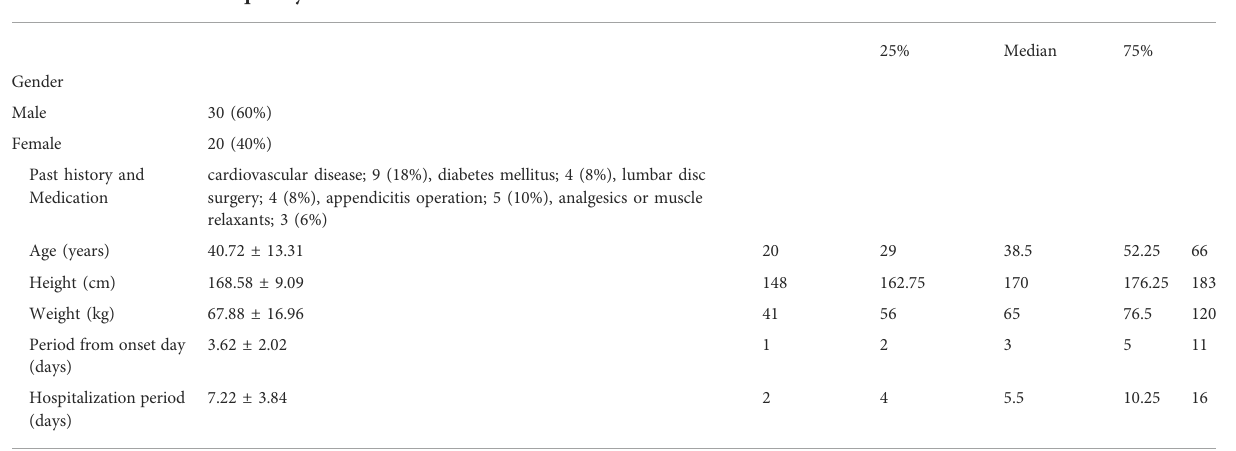
TABLE 2 Demographic Characteristics of